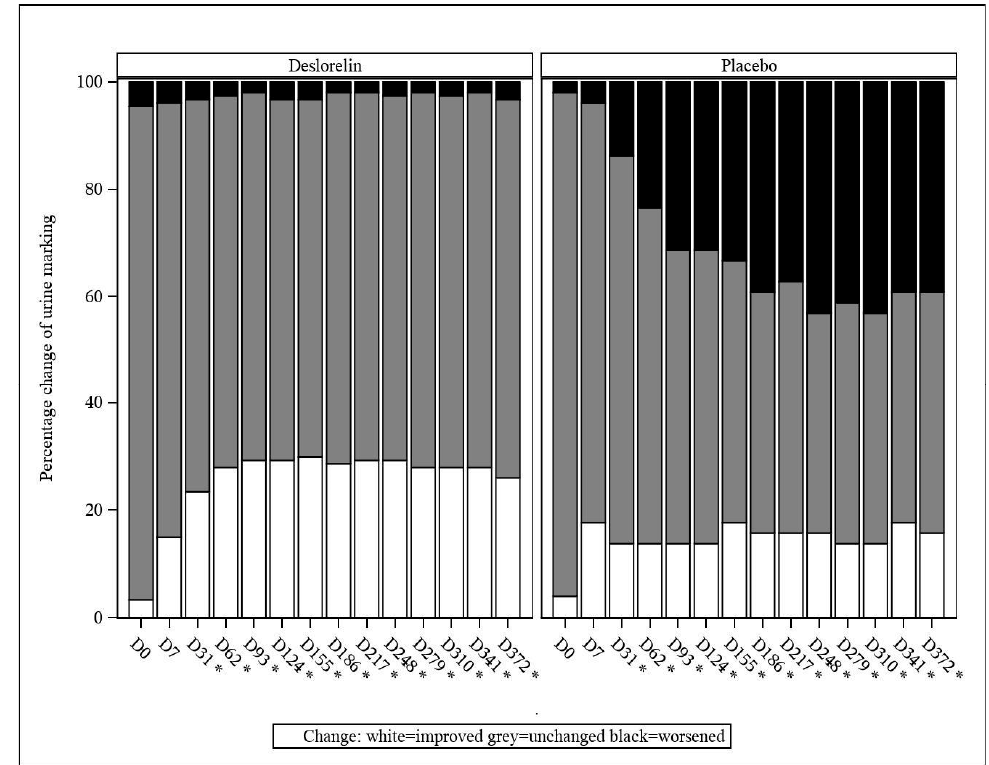
Figure 3. Percentage change in urine marking compared to baseline. * Significant difference ( p < 0.001) between groups from D31 onwards.